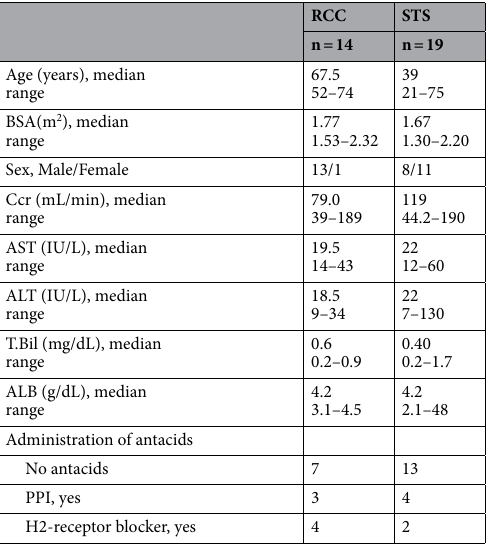
Table 1. Patient characteristics. BSA, Body surface area; CCr, Creatinine clearance; AST, Aspartate aminotransferase; ALT, Alanine aminotransferase; T.Bil, Total bilirubin; ALB, Albumin; PPI, Proton pump inhibitor; H 2 blocker, Histamine 2